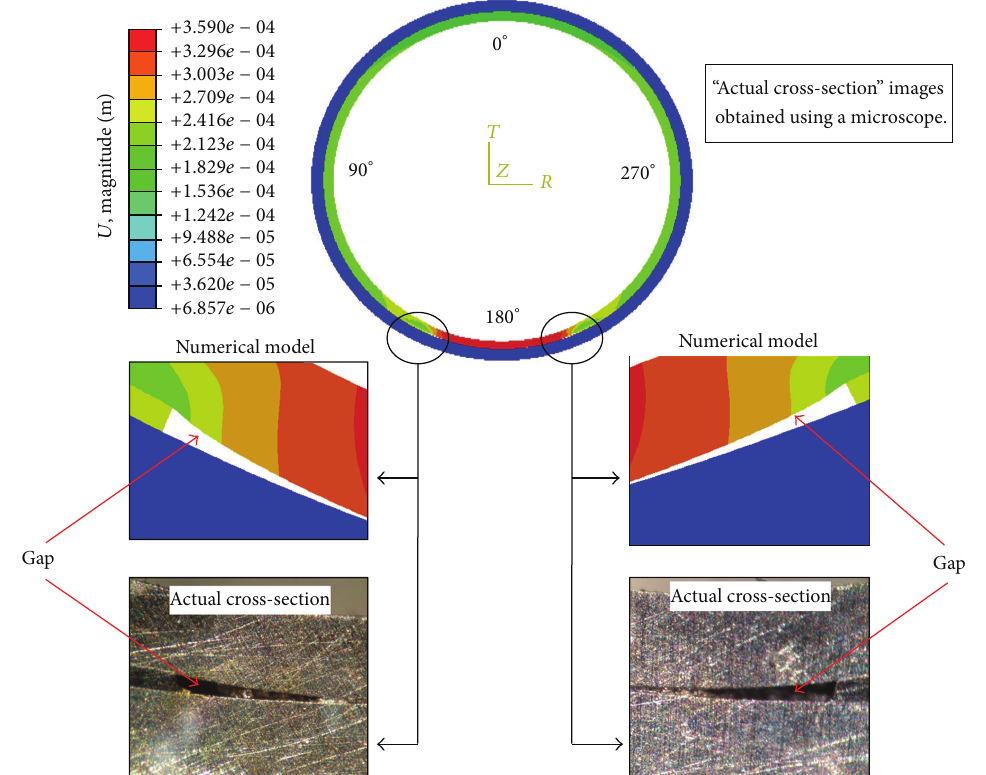
Figure 8: Postassembly numerical displacement contour and microscope images.